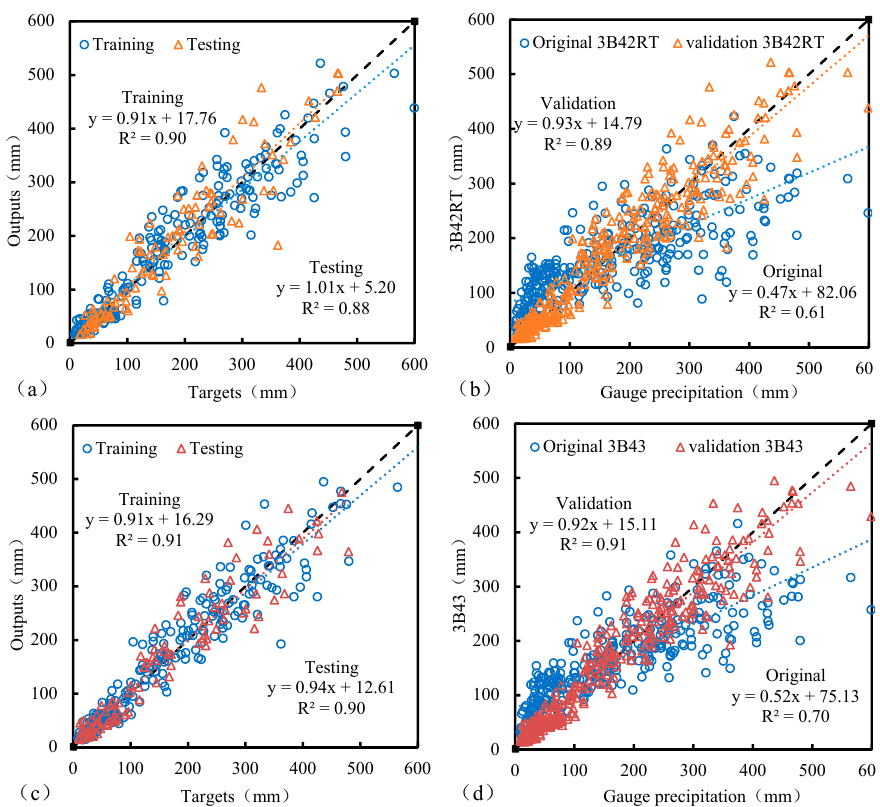
Figure 5. The calibration and validation of TRMM precipitation by artificial neural networks (ANN). ( a ) Training and testing for 3B42RT; ( b ) correction for 3B42RT; ( c ) training and testing for 3B43; ( d ) correction for 3B43.